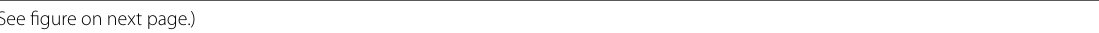
figure on next Fig. 1 Place of the species belonging to the genus Protadelomys and ? Protadelomys on the phylogenetic tree from Vianey‑Liaud and Marivaux (2021, Fig. 4), replaced on a stratigraphic scale. In that paper, the species marandati and hautefeuillei makes a clade, separated from their sister species, russelli . For this reason, and the reevaluation of their morphological features, they are both referred to the genus Hartenbergeromys . In the cited paper, the generic attribution of several other species has been changed because of morphology and phylogenetic relationships ( cezannei has been changed from Pseudoparamys to Corbarimys; inexpectatus from Euromys to Ailuravus , lapicidinarum from Plesiarctomys to Pseudoparamys